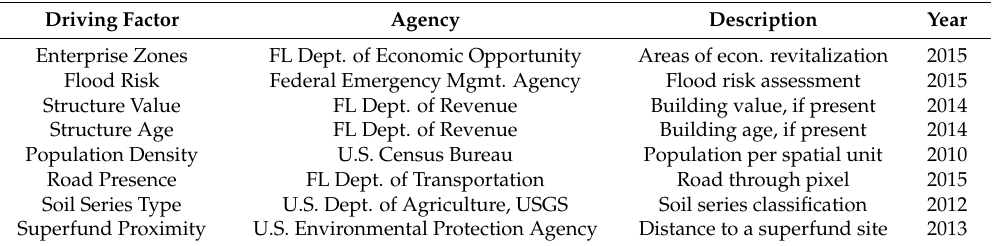
Table 2. List of Driving Factors of LULC change to parameterize binomial logit regression models.